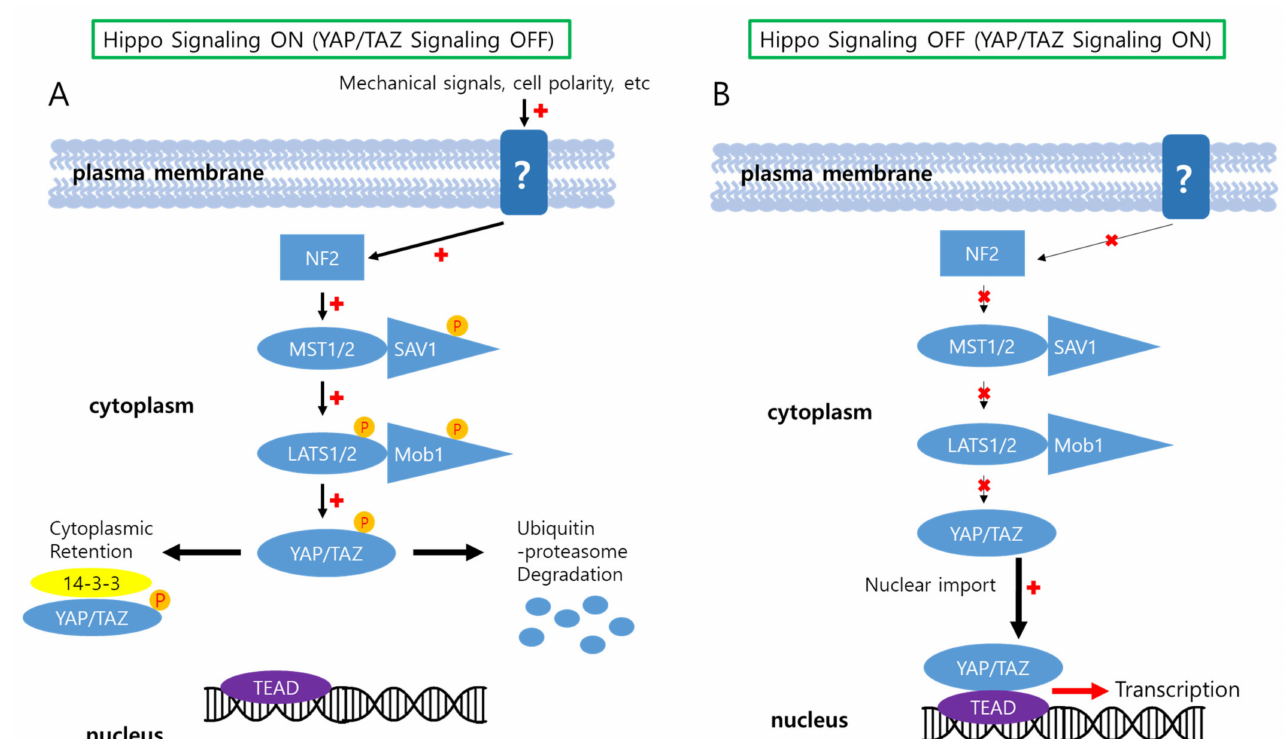
Figure 1. Schematic illustration of Hippo-YAP/TAZ signaling pathway. A variety of cellular con- ditions in tissue such as cell density, extracellular matrix (ECM) stiffness, or cell polarity can elicit signals regulating the Hippo signaling cascade. Receptors sensing the cellular conditions have yet to be identified. ( A ) When the Hippo signaling is turned on, sequential phosphorylation processes by kinase components of the pathway lead to phosphorylation of YAP/TAZ, resulting in cytoplasmic retention or degradation of the transcription factors. ( B ) When the Hippo signaling is turned off, unphosphorylated YAP/TAZ can translocate into the nucleus, where they interact with TEAD and transcriptionally activate numerous target genes. The Hippo–YAP/TAZ signaling pathway presented in the figure is tightly regulated in hepatocytes, the parenchymal cells in the